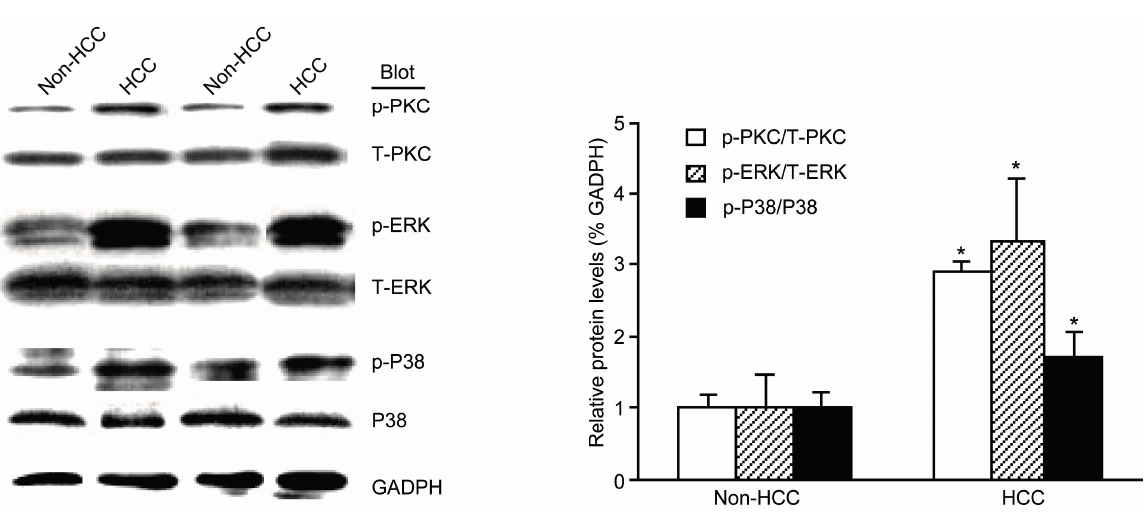
Figure 3. HCC induced the phosphorylation of PKC, ERK, and p38 MAPK. Western blot analysis and quantitation of PKC, ERK, and p38 MAPK normalized against GADPH. Data are mean ± SE ( n = 5, * p < 0.05 compared with non-HCC).